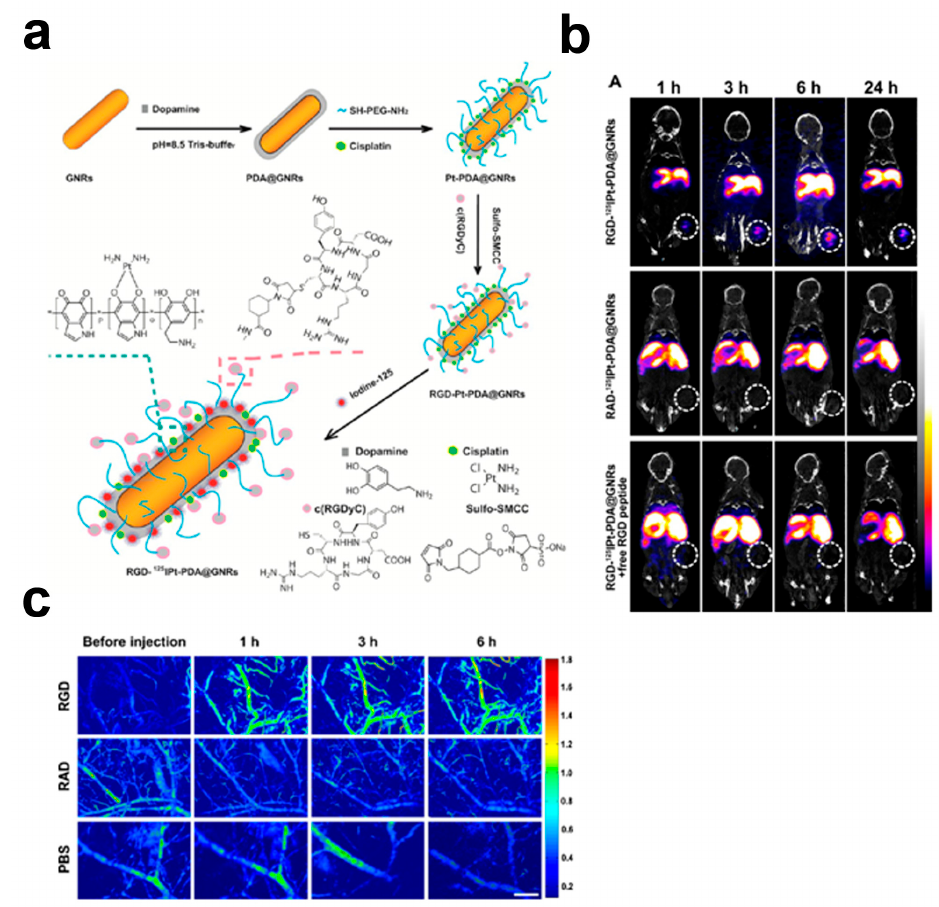
Figure 3. ( a ) Schematic illustration of the polydopamine (PDA)-coated gold nanorods (GNR) labeled with 125 I, loaded with cisplatin (Pt), and conjugated to the arginine-glycine-aspartic acid (RGD) peptide targeting α v β 3 integrins; ( b ) single-photon emission computed tomography/computed tomography imaging of tumor-bearing mice after intravenous injection with RGD- 125 IPt-PDA@GNRs, RAD- 125 IPt-PDA@GNRs (non-targeting peptide), or RGD- 125 IPt-PDA@GNRs probes plus free RGD peptide (100 μ L, 0.15 mM), at a radiation dose of 300 μ Ci, showing the targeting specificity of the RGD peptide to the α v β 3 integrins; ( c ) optoacoustic imaging of tumors after intravenous injection with RGD- 125 I-Pt-PDA@GNRs (RGD) at a dose of 40 mg Au/kg b. w., and RAD- 125 IPt-PDA@GNRs (RAD) as a control. Scale bar = 10 μ m. Reprinted with permission from reference [35], Copyright 2016, American Chemical Society.